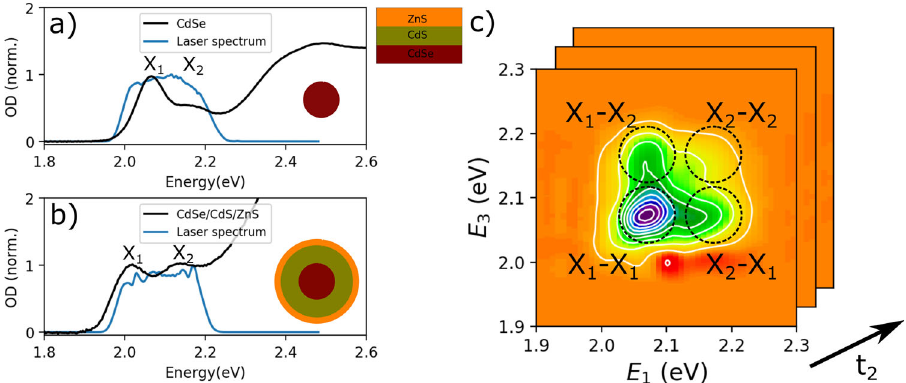
Fig. 1 Schematic overview of two-dimensional electronic spectroscopy (2DES) as a probe of the electronic structure of quantum dots. a Linear absorption spectrum of CdSe quantum dots (QDs) in black and laser spectrum used in 2DES experiment in blue, where OD is the normalized optical density. X 1 is the fi rst excitonic state and X 2 is the second excitonic state. b Linear absorption spectrum of CdSe/CdS/ZnS core/shell QDs in black and laser spectrum used in 2DES experiment in blue. The insets in panels a and b show the QD material layers. c Diagram labeling the four main peaks in the 2DES spectrum for CdSe QDs. The peaks are labeled by the excitation state followed by the emission state. E 1 is the 2DES excitation energy, E 3 is emission energy, and t 2 is the time delay between the pump pulses and the probe